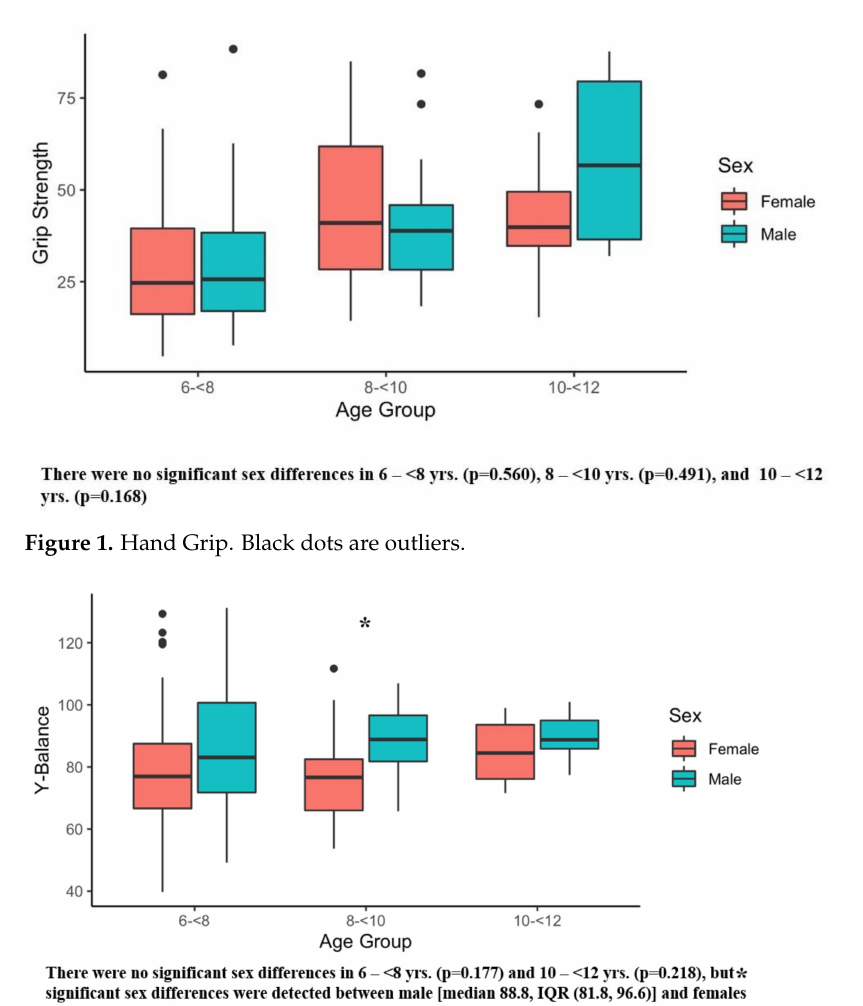
Figure 2. Y-balance. Black dots are